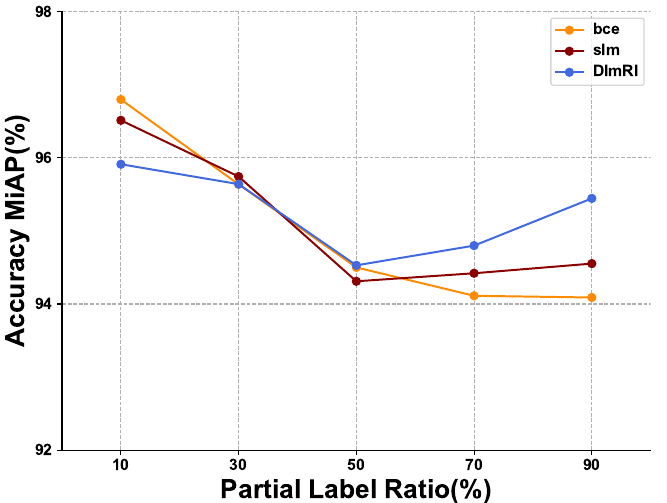
Figure 5. The figure shows the MiAP score (%) of three different loss methods on VOC2007 with partial labels. The orange line indicates the accuracy rate using BCE with Logits Loss (bce): the red line indicates the accuracy rate using MultiLabel SoftMargin Loss (slm); and the blue line indicates the accuracy rate using our